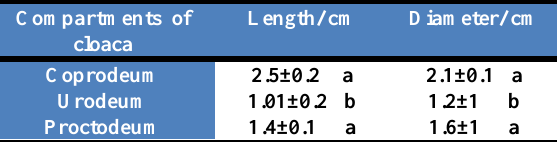
Table, 1: Show the morphological parameters (length and diameter) of the three compartments of cloaca.